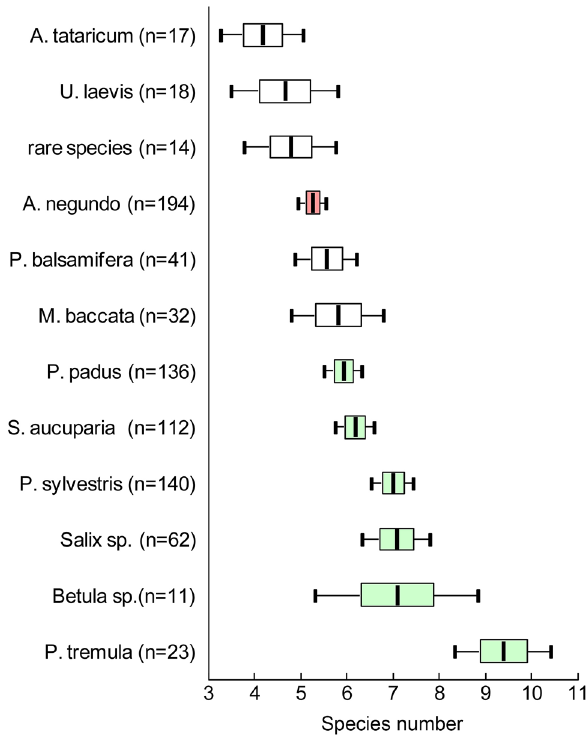
Figure 7. Average number (± SE, ± 95CI) of observed ground cover species per m 2 on plots under the canopies of different native (green plots) and alien (white and pink plots) tree species; rare species—the indication for a group of plots dominated by species rarely found in the studied site ( Amelanchier spicata , Caragana arborescens